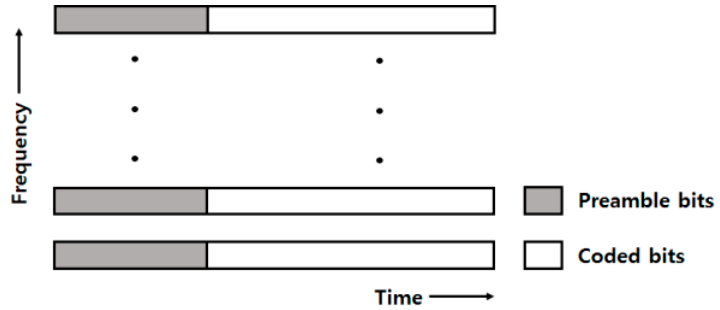
Figure 1. Packet structure for multi-band transmission .